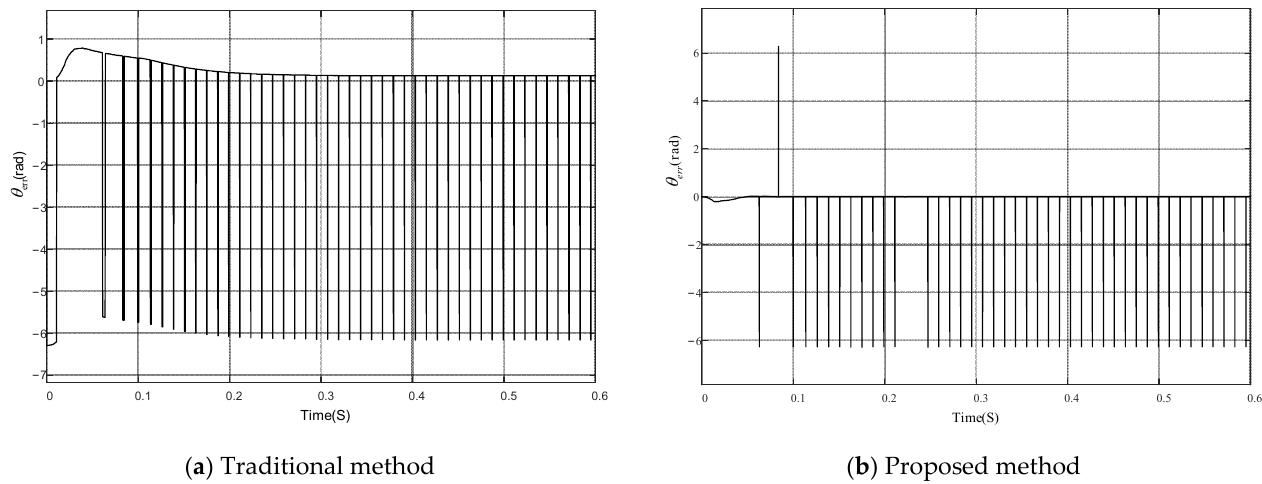
Figure 9. Estimation error of rotor position waveforms at 1000 r/min. In the simulation experiment to verify the accuracy of the parameter identification algorithm, the paper directly sets the motor speed to 1000 r/min and the load torque to 1.27 N.m. The parameter identification curves of are obtained as shown in L , R , and f s Figure 10. We can know from Figure 10 that the parameter identification using the Adaline neural network has fast response speed and high identification accuracy when the motor is running stably.